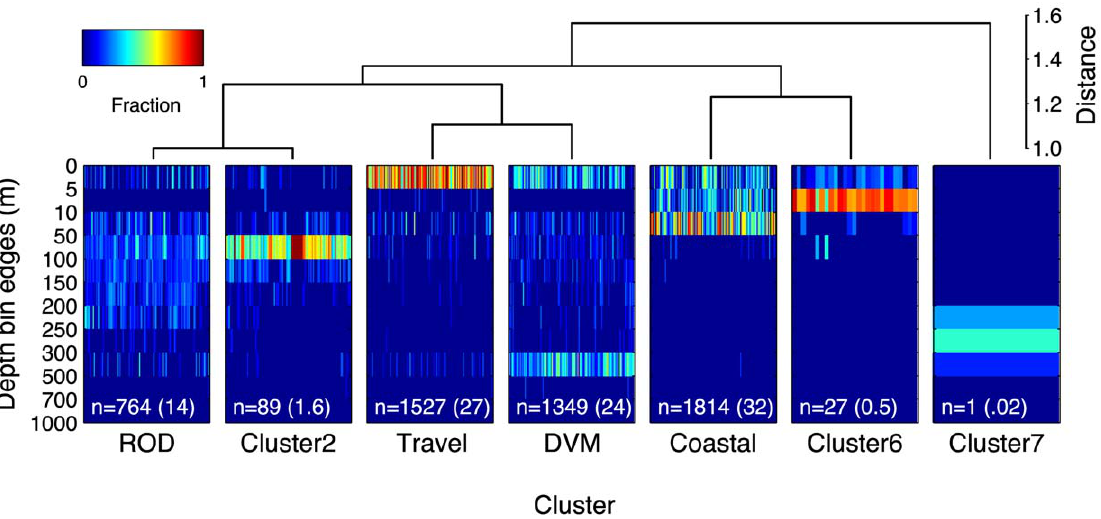
Figure 1. Dendrogram of white shark behavior, determined from clustering analysis of differences in diving patterns. Each column represents a 24-hour depth histogram (n=5571 days from 53 sharks) and is colored by fraction of time. Distinct vertical distribution patterning is evident in the grouping of days with similar depth distributions. The size of each cluster, is indicated by the number of days (n), and percent of total days (in parentheses). The density variable is expressed as a fraction of each day spent in depth bins defined along the y-axis. doi:10.1371/journal.pone.0047819.g001 There were distinct vertical velocity signatures associated with different diving modes and in some cases these differed by sex (Table 1). The Coastal mode was characterized by the lowest vertical velocity, and was similar for both males and females ( , 0.04 m/s). Offshore, when not traveling, females moved on average at a consistent vertical rate ( , 0.1 m/s) regardless of mode (DVM or ROD) or location (Hawaii or Cafe´). In contrast, male movement was more rapid vertically for Travel, DVM and ROD.